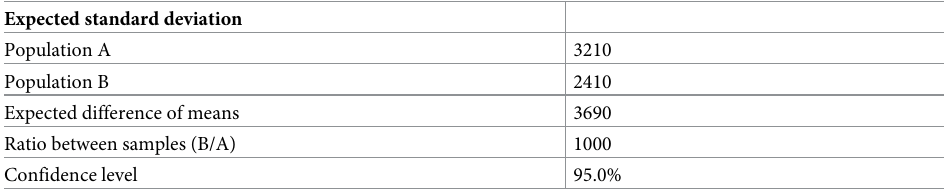
Table 2. Sample size Calculation